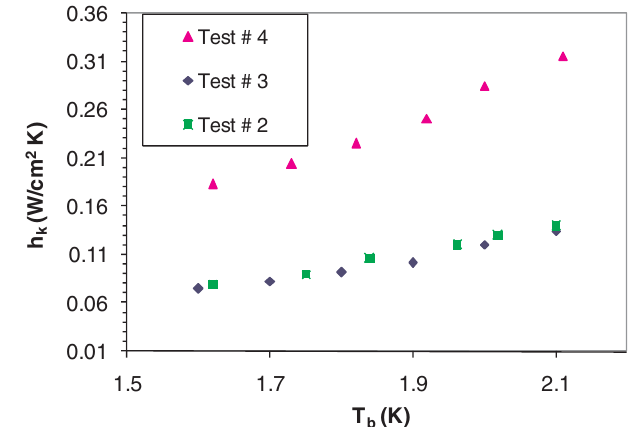
FIG. 14. (Color) The Kapitza conductance of the sample S2 surface with SI > 3 (test #2) and the effect of low temperature annealing with SI > 3 (test #3) is compared with the machine cut surface (test #1). Literature data is adapted from Bousson et al.